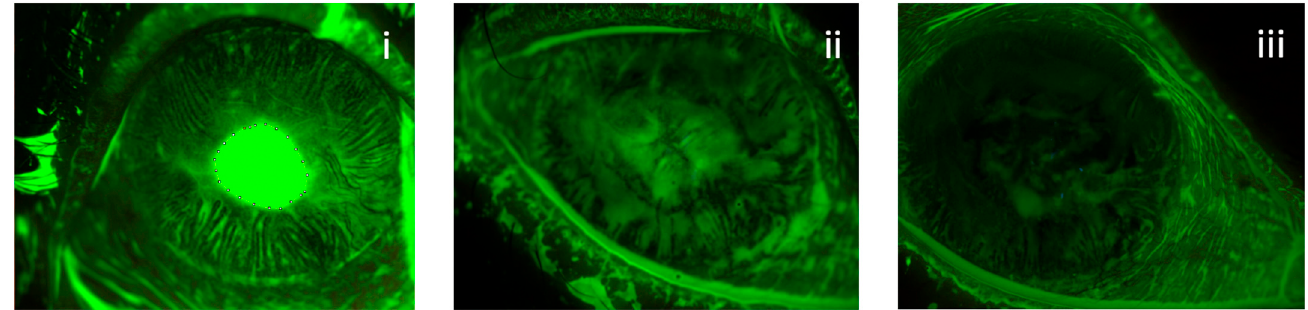
Figure 1. Reduction in ulcer’s area in a patient with post-herpetic NK treated with rh-NGF. The extension of the defect was calculated with ImageJ software at baseline ( i ), 4 weeks ( ii ) and 8 weeks ( iii ).